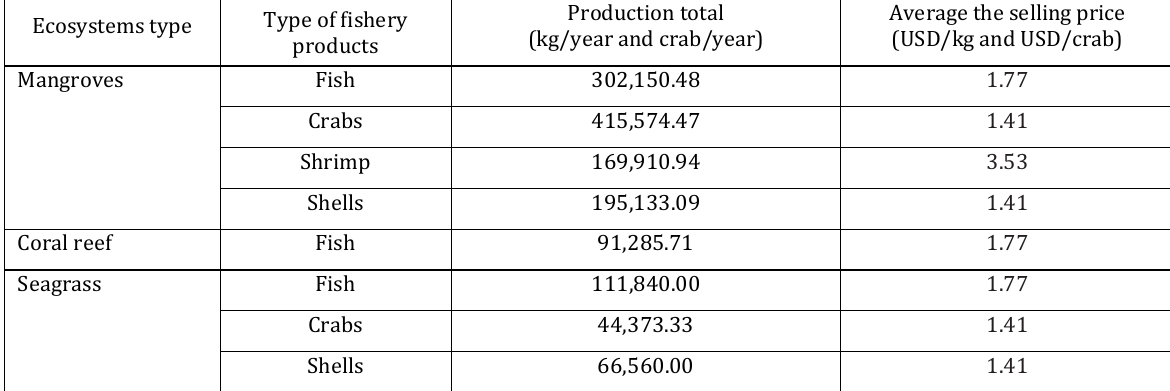
Table 1. Type and number of fishery products from CES in the coastal area of Jayapura City, Papua Province, Indonesia Ecosystems type